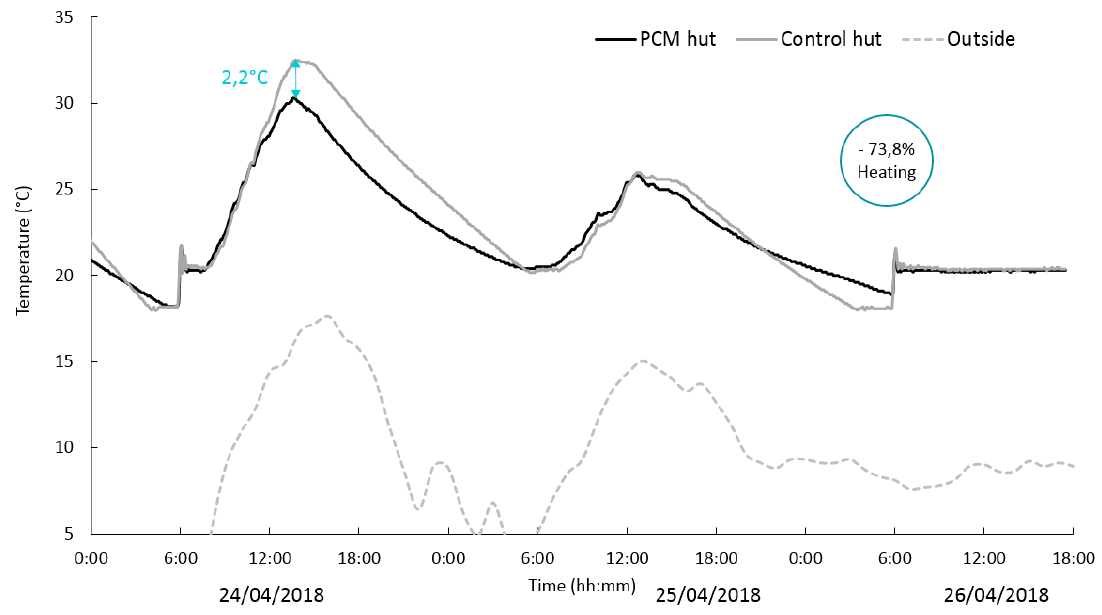
Figure 7. Behaviour of the test huts for consecutive days.